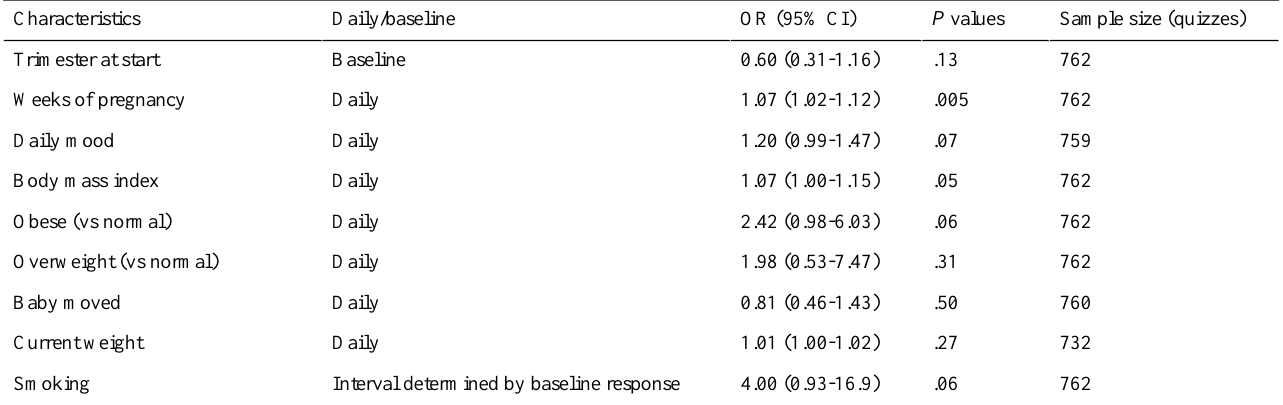
Table 5. Daily and baseline characteristics and their associated odds ratio of missing at least one day of daily quizzes given current levels of these characteristics using a generalized mixed logit